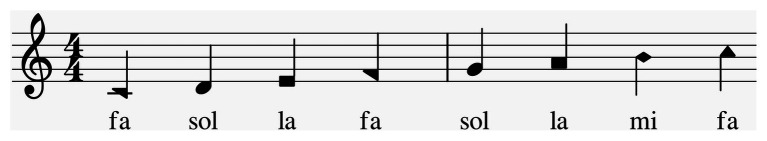
The four-shape system uses four solfege syllables and their accompanying shapes to indicate the seven scale degrees. This system is used in The Sacred Harp, The Shenandoah Harmony, and The Southern Harmony.